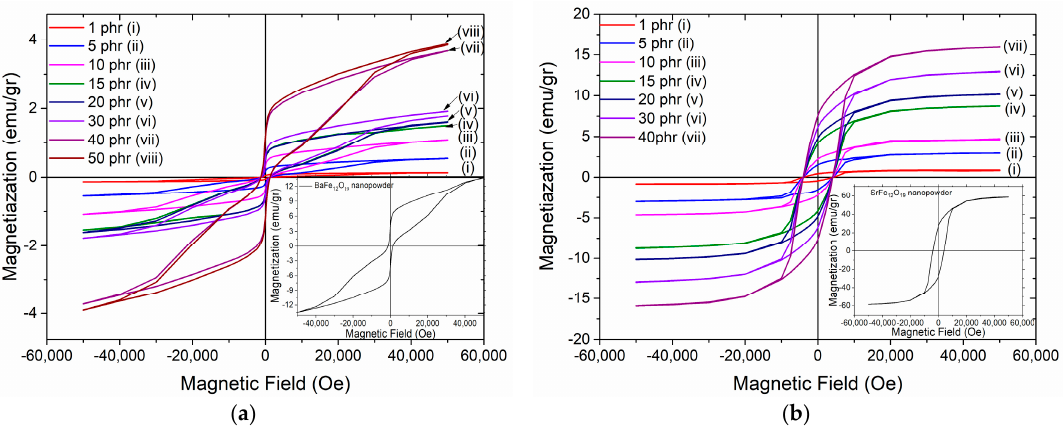
Figure 9. Magnetic hysteresis loops for the nanocomposites with varying: ( a ) BaFe 12 O 19 ; ( b ) SrFe 12 O 19 filler content. Insets depict the hysteresis loops of their respective nanopowders.